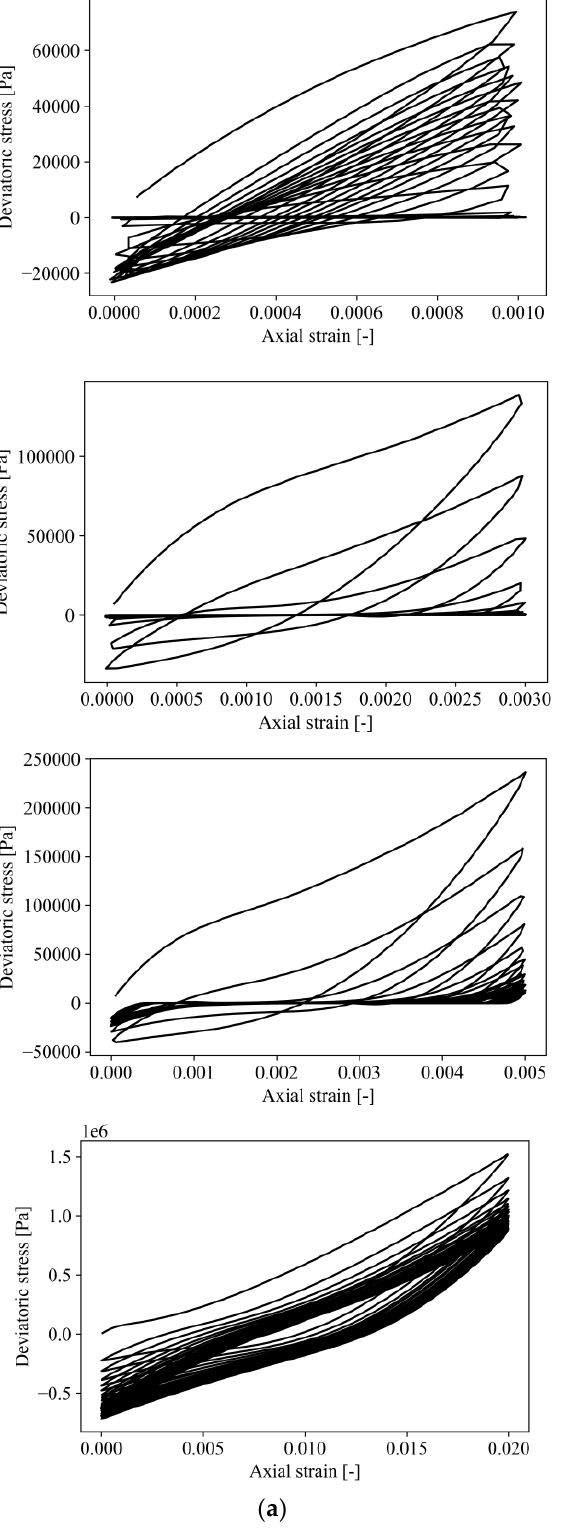
Figure 8. Results of the cyclic triaxial testing for medium-dense sand: ( a ) deviatoric stress – strain hysteresis curves; ( b ) evolution of the deviatoric stress with the increase of the number of cycles. Remarkably, the samples subjected to low axial strain corresponding to 0.1 – 0.5% show an important and gradual loss of shear resistance whilst at larger strain levels, the hysteresis loops after an initial partial degradation and become stable, showing a behavior